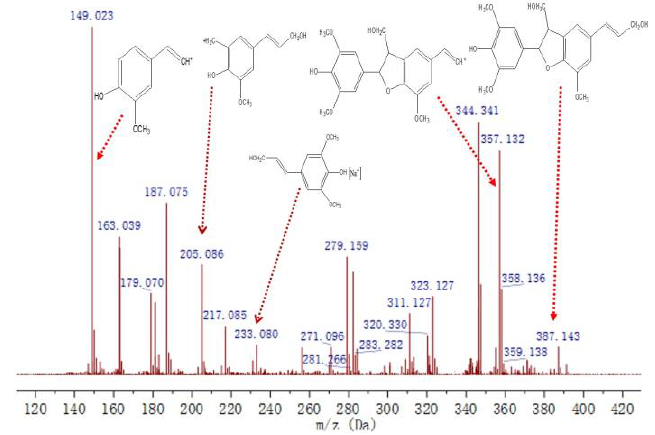
Figure 14. Mass spectrum of the compound GS 1 .